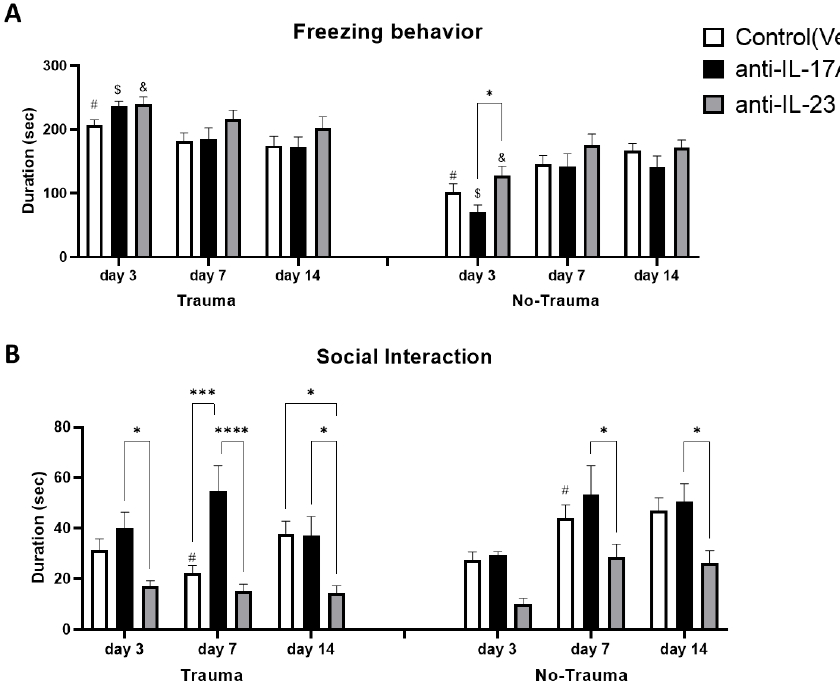
Figure 7. Exposure to trauma and antibody treatment affect trauma related behavior. At days 3, 7 and 14 following the exposure to trauma, mice were placed in the same arena in which they were exposed to the electric shock trauma for 5 min. Freezing behavior was measured as the duration of total inactivity by Ethovision TM tracking system. ( A ) A graph presenting inactivity duration in the different sub-groups (Trauma: anti-IL-17A n = 15, anti-IL-23 n = 13, Control n = 24. No trauma: anti-IL-17-A n = 17, anti-IL-23 n = 14, Control n = 24). Social behavior was assessed as the duration of interaction between the tested mice and a novel unfamiliar mouse for 5 min, 3, 7- and 14-days following the exposure to trauma. ( B ) A graph presenting interaction duration in the different sub-groups (Trauma: anti-IL-17A n = 16, anti-IL-23 n = 12, Control n = 24. No trauma: anti-IL-17-A n = 17, anti-IL-23 n = 12, Control n = 24). All data in the graphs is presented as mean ± SE. * p < 0.05, *** p < 0.0005, **** p < 0.0001. Paired symbols represent statistical significance between the two corresponding groups: $ p < 0.05, & p < 0.05, # p < 0.05.